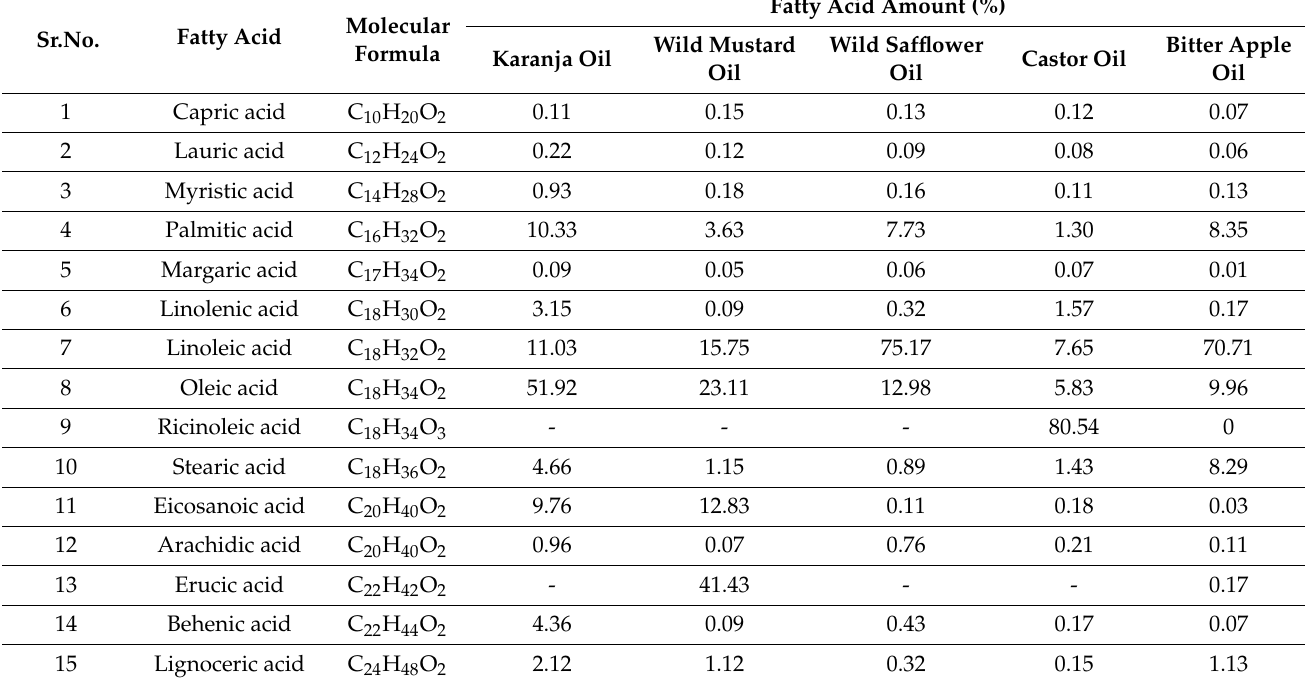
Table 9. The chemical composition of used